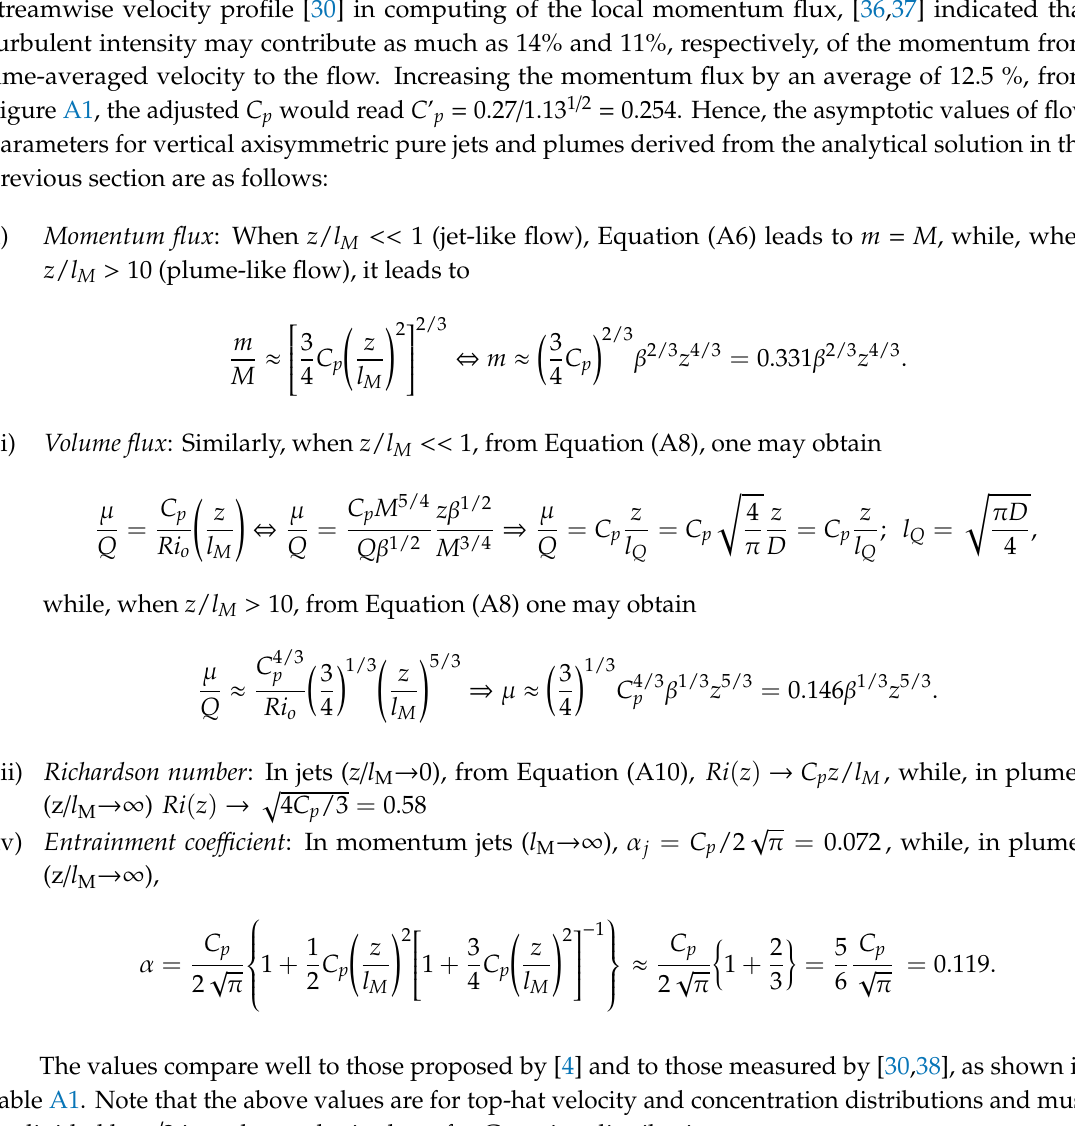
√ be divided by 2 in order to obtain those for Gaussian